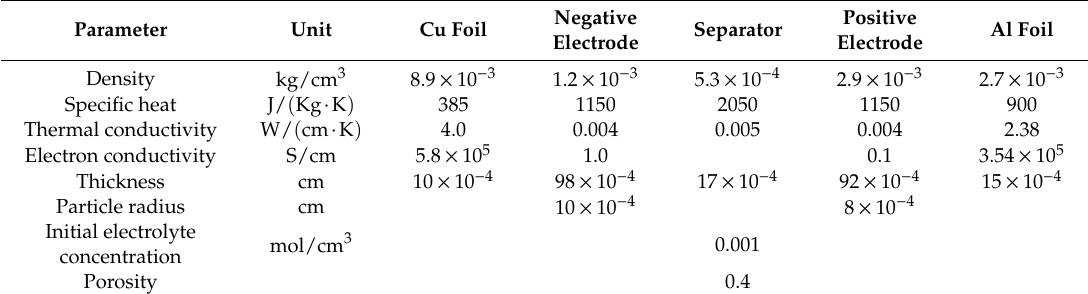
Table 3. Physiochemical parameters used in the axisymmetric